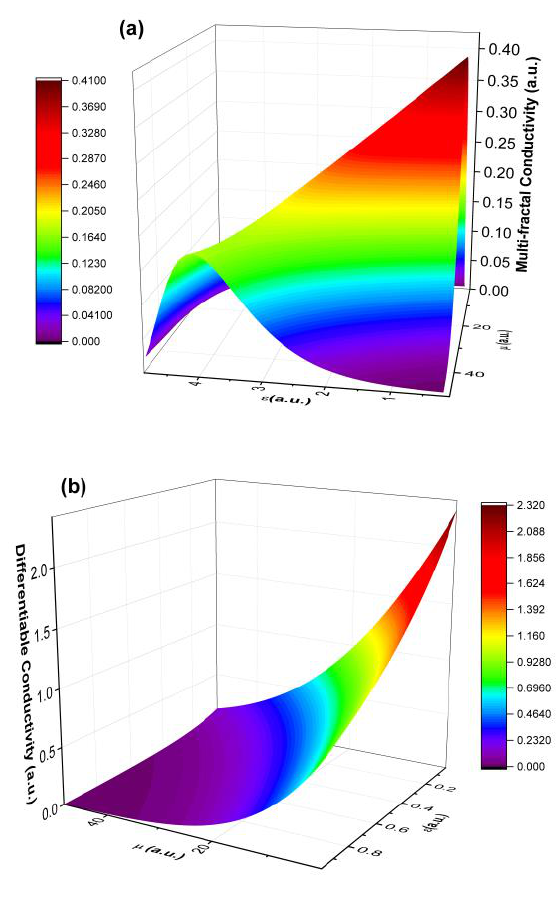
Figure 5. Three-dimensional representation of the two types of conductivities derived from the multifractal model.